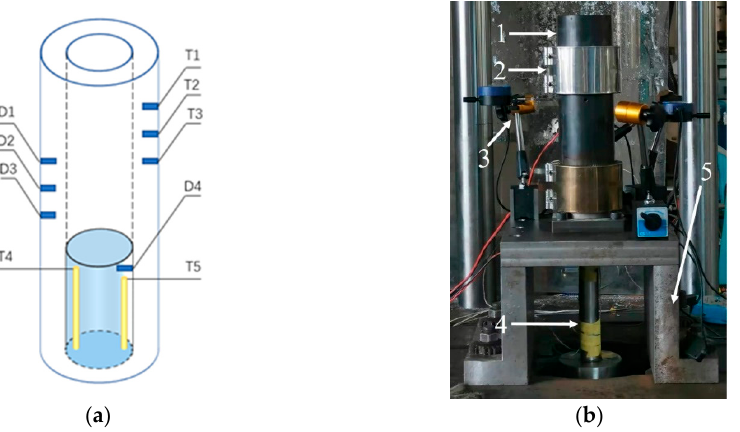
Figure 3. Experimental device: ( a ) Measuring points’ positions; ( b ) testing photo. Note: 1—shot sleeve; 2—preheating ring; 3—micrometer rangefinder; 4—pushing rod; 5—base.